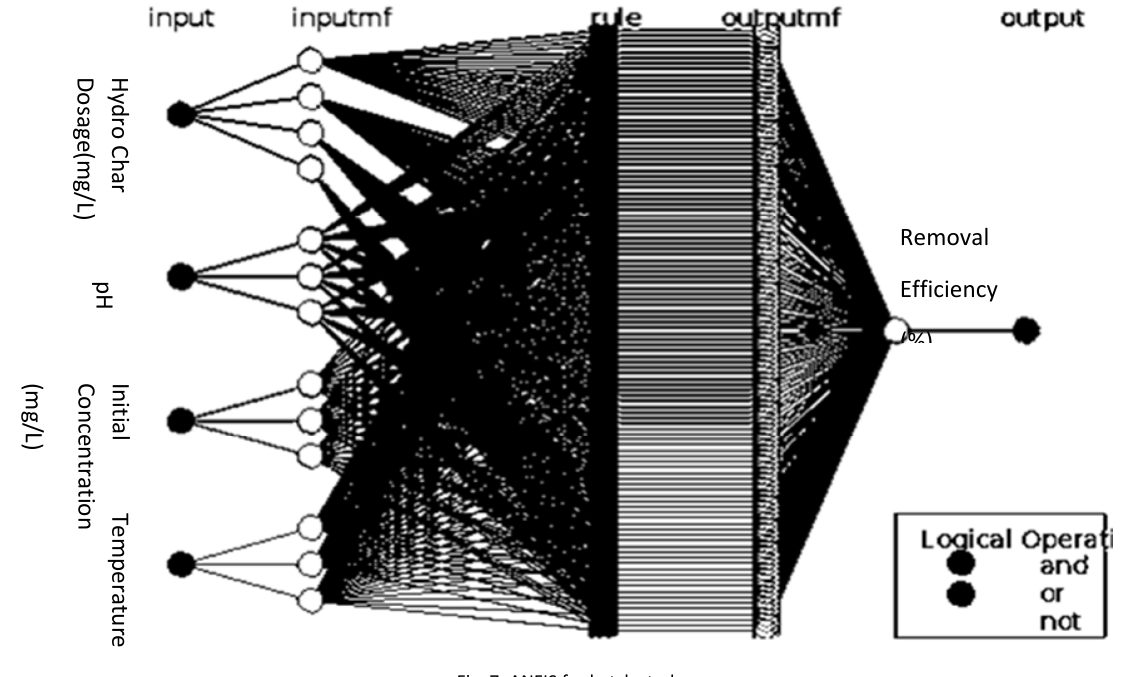
Fig. 7: ANFIS for batch study